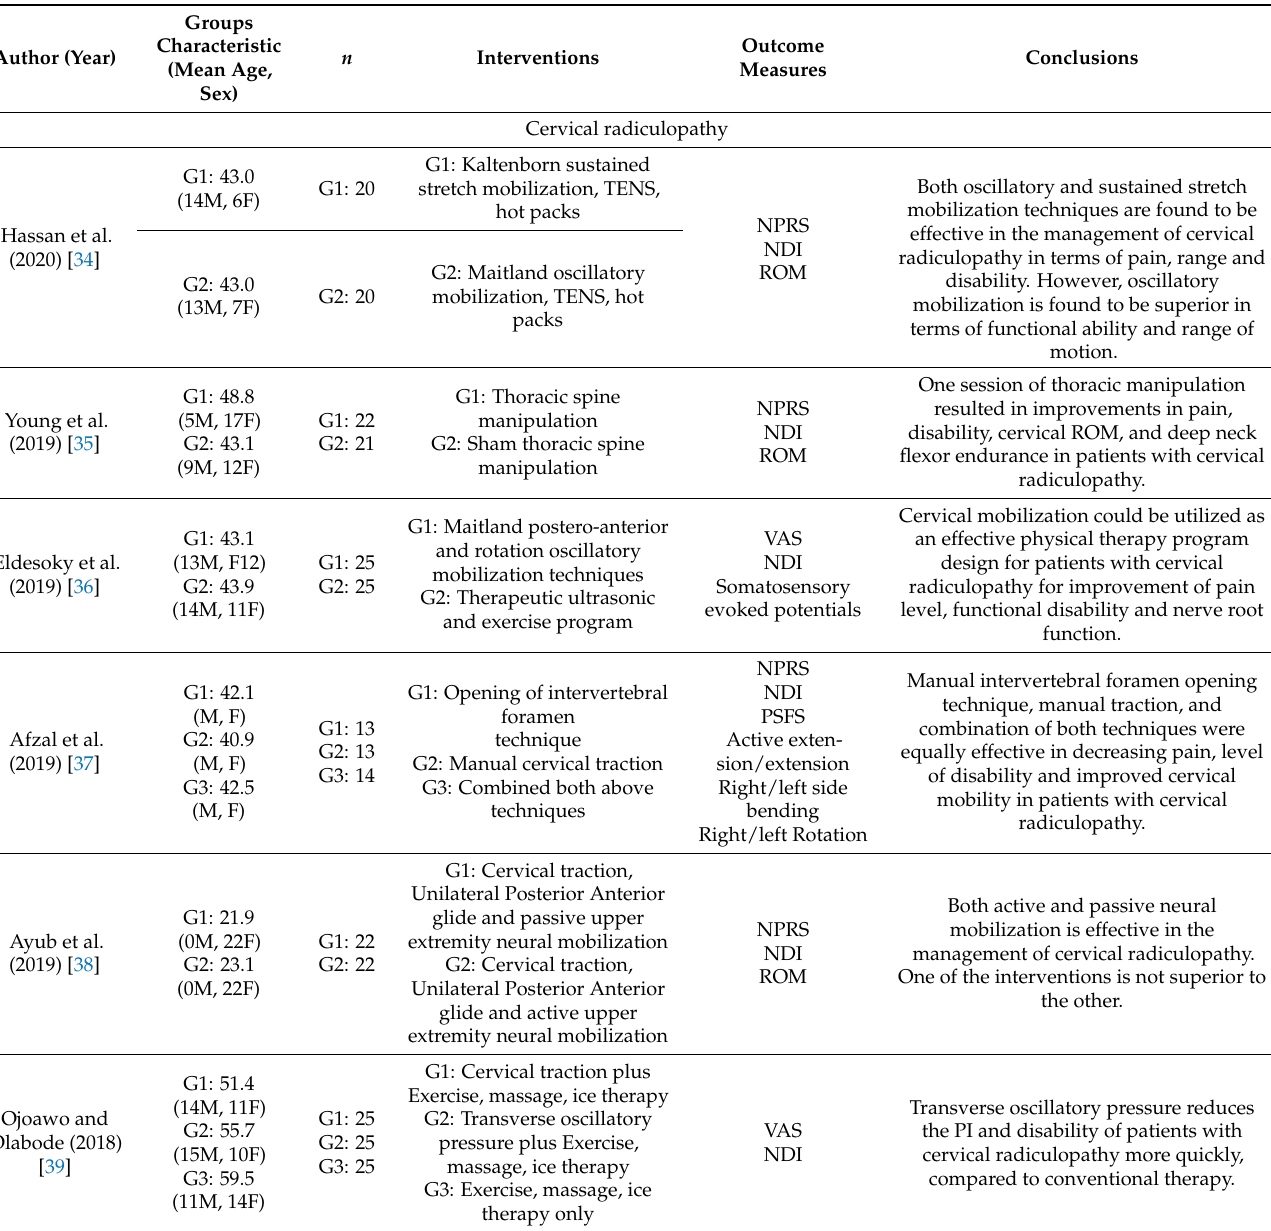
Table 2. Characteristics of included